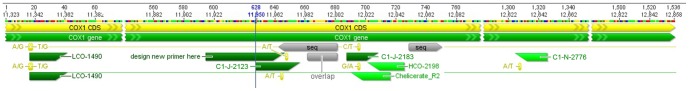
The new primer C1-J-2123 binding site is 60 bp upstream of the C1-J-2183 binding site.